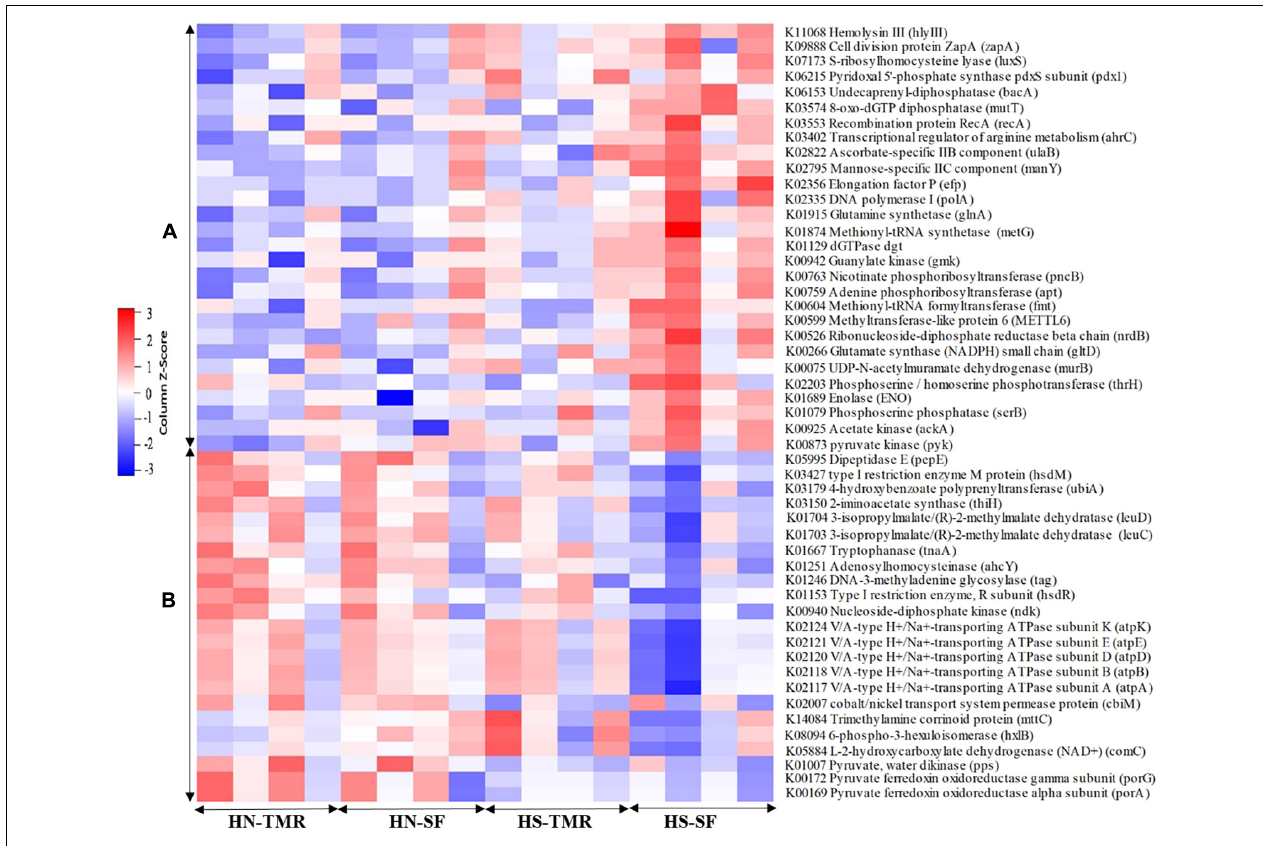
FIGURE 7 | Heatmap of the relative abundance of microbial genes negatively (A) and positively (B) associated with methane production, as identified by Kendall rank correlation analysis. The scale colours denote whether the abundance is high (closer to 1, red squares) or low (closer to − 1, blue